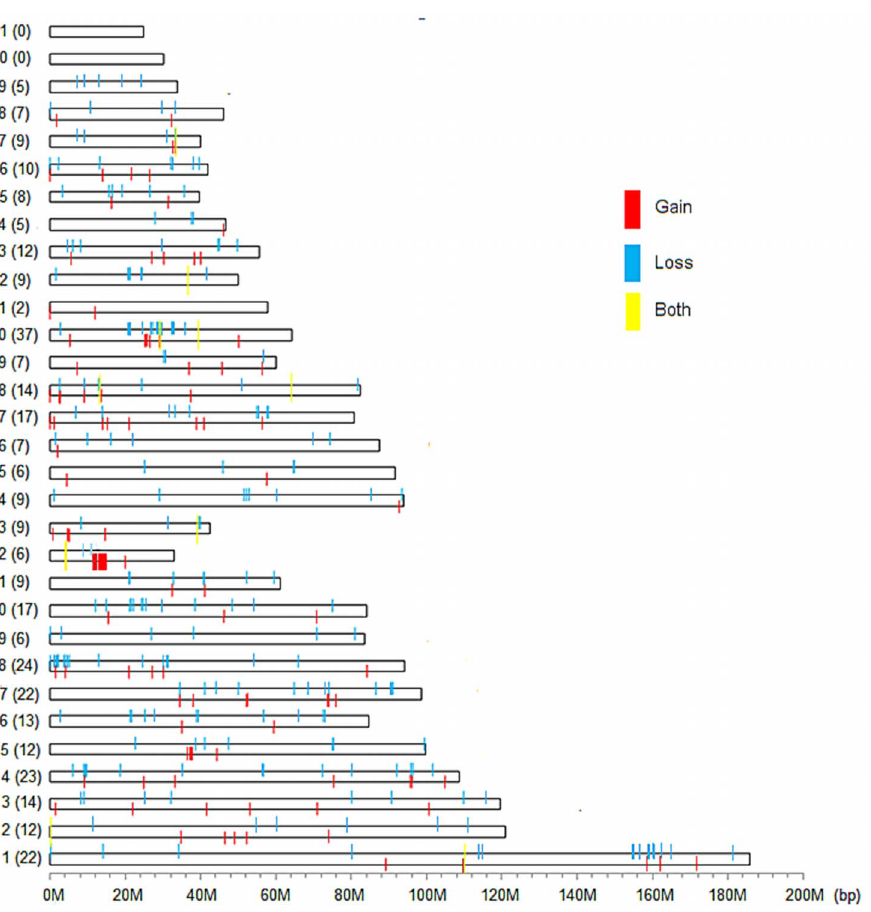
Figure 2. Distribution of CNVRs in the horse genome. Numbers in parentheses represent CNVRs. The red represents gain CNVRs. The light blue represents loss CNVRs. The yellow represents both CNVRs.